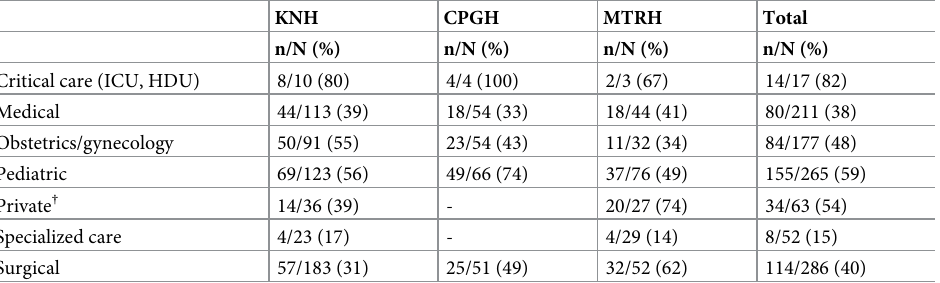
tively. Of the 484 patients whose HIV status were documented, 61% (50/82) of those with a HIV-positive status were receiving an antibiotic compared with 45% (182/402; P = 0.01) of HIV-negative patients. Table 3. Distribution of antibiotic users (n = 489) by ward type at Kenyatta National Hospital (KNH), Coast Pro- vincial General Hospital (CPGH) and Moi Teaching and Referral Hospital (MTRH), 2017–2018, Kenya.